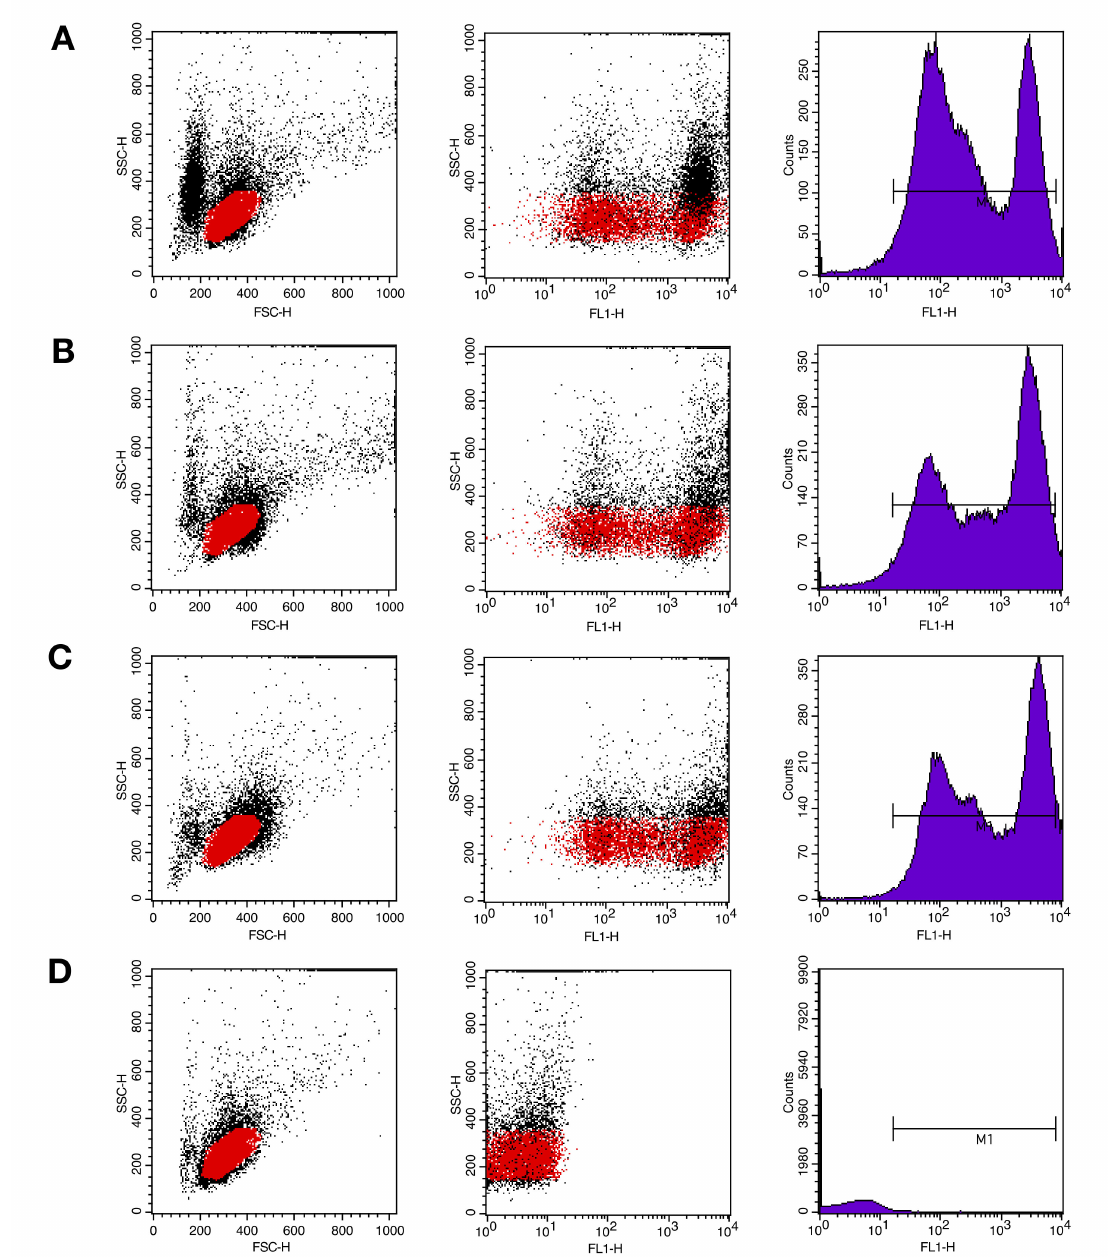
Figure 7. Flow cytometric analysis of the IgMHC µ 1 mAb by quantification of IgM + cells in the PBLs of bighead catfish ( A ), African catfish ( B ), hybrid catfish ( C ), and zebrafish ( D